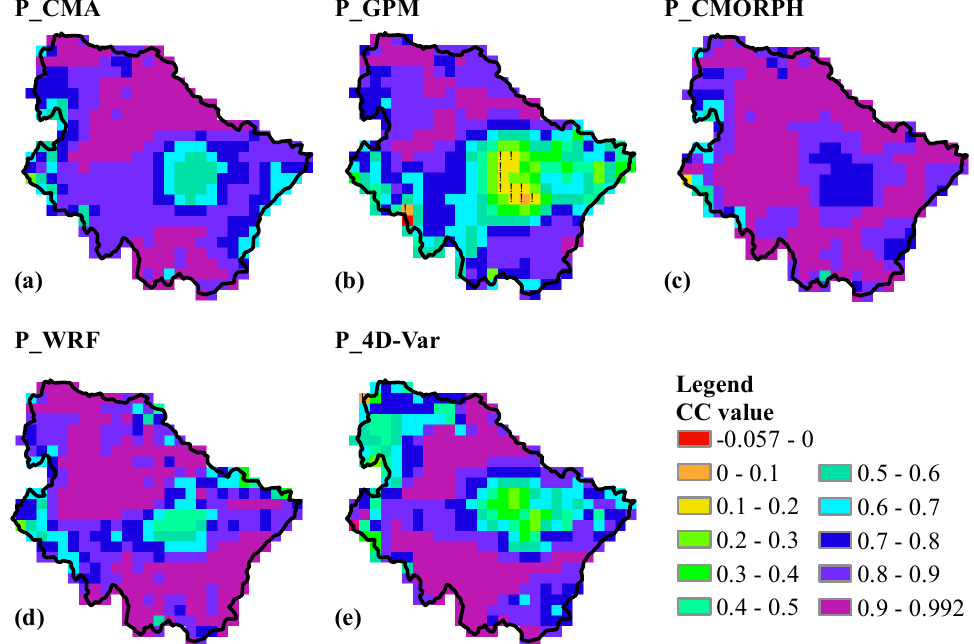
Figure 11. Pearson’s correlation coefficient ( CC ) between the SMAP soil moisture and the soil moisture simulated by the rainfall-runoff experiments of P_CMA ( a ), P_GPM ( b ), P_CMORPH ( c ), P_WRF ( d ) and P_4D-Var ( e ) at 3-h intervals. The point denotes the CC value, which is not statistically significant at the level of 0.05.